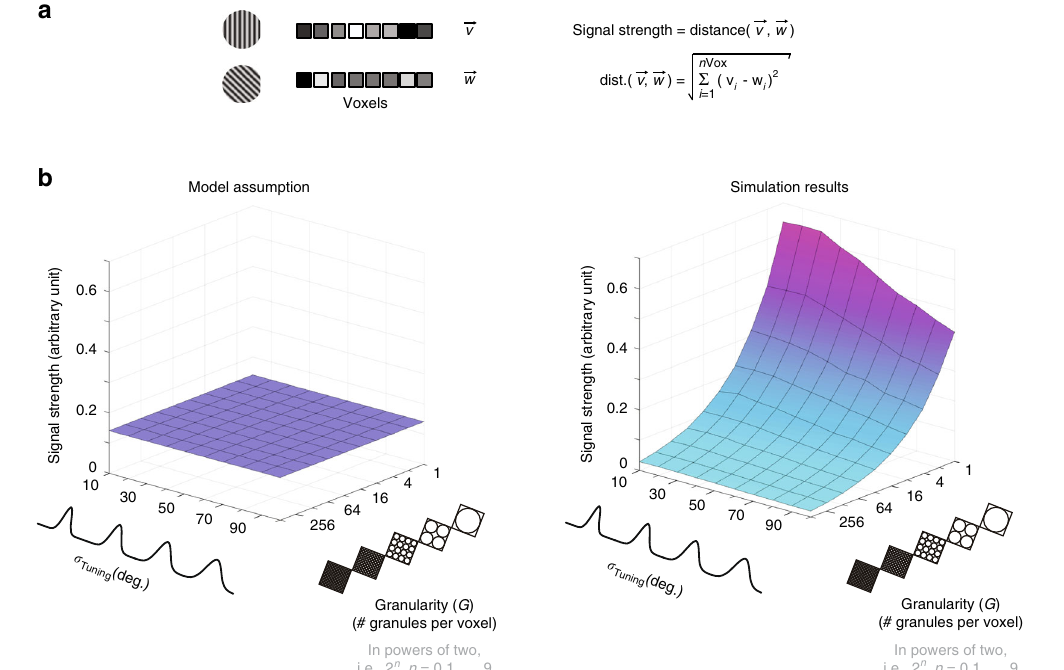
Fig. 2 Noise amplitude and signal strength in fl uence empirically observed fMRI – pattern correlations. a fMRI patterns formed by concatenating responses across voxels for each of two experimental conditions — here, visual gratings oriented either 45° or 90° from the horizontal. The strength of the signal component distinguishing the brain responses associated with these two gratings can be quanti fi ed as the Euclidean distance between these two spatially distributed brain response patterns, treated as vectors, and denoted here as ~ v and ~ w . b Simulation results: signal strength as a function of tuning bandwidth and granularity. In the class of models implemented by Alink et al., the tuning bandwidth of feature-tuned neural populations has been parametrized by Gaussian distributions. The preferred orientation of each neural population is described by μ Tuning , while σ Tuning describes how tightly tuned each population is about its preferred orientation. In turn, the level of granularity of simulated fMRI data has been controlled by a positive integer ( G ) specifying the number of similarly tuned neural clusters, here referred to as granules, assumed to be sampled by each voxel 13 . The 3D surface shown to the right under the label “ Simulation results ” clearly demonstrates that granularity ( x -axis), as well as tuning width ( y -axis), in fl uence the strength of simulated fMRI patterns. For each admissible parameter combination of G and σ Tuning the z -axis indicates the average strength (across 25 randomly seeded simulations) of the signal distinguishing the fMRI response patterns denoted by ~ v and ~ w . The full range of simulated granularity levels is [1, 512] (2 n , with n = 0, 1, … , 9 granules per voxel). A dramatic effect of granularity on signal strength can be noted along the x -axis. If granularity were irrelevant, the observed monotonically decreasing curve would be instead a fl at line. Given that pairwise correlations are known to be determined by noise amplitude as well as signal strength, this simulation demonstrates that the validity of inferences regarding neural coding based on fMRI – pattern correlations depend on granularity assumptions as well as noise